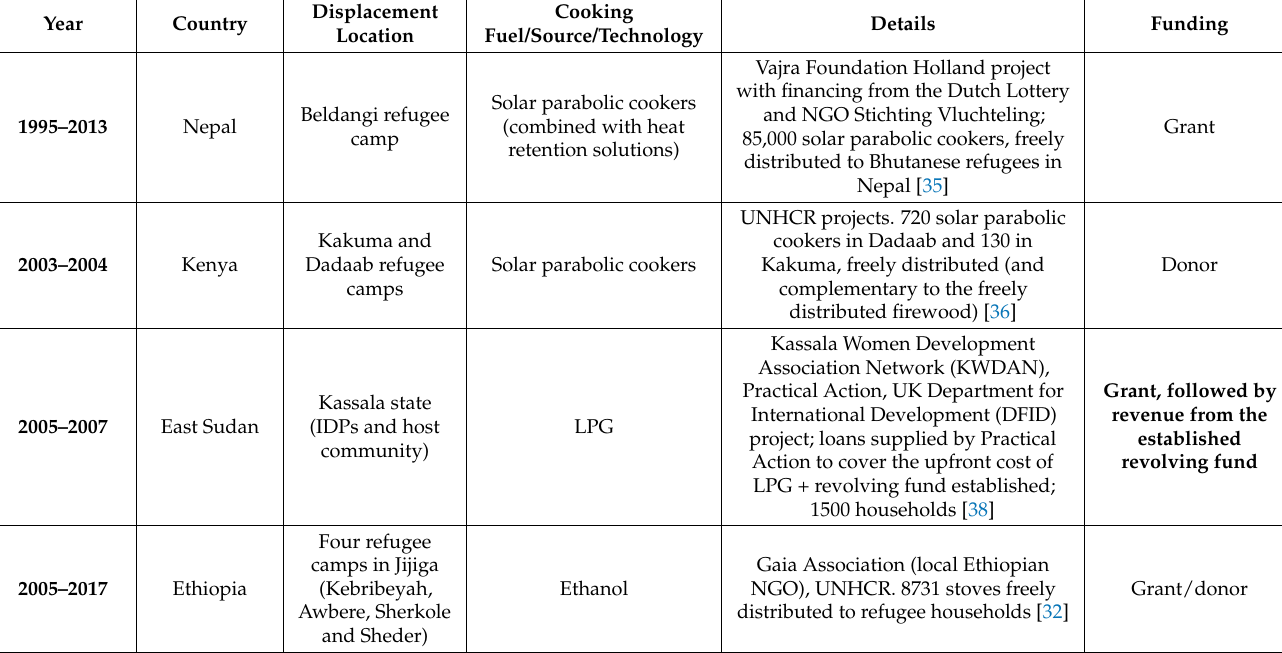
Table 1. MECS projects in displacement settings (1995–2021). Marked in bold under ‘Funding’ are MECS projects which had a component of non-grant/donor funding or innovative financing. Adapted from Tran, Bisaga and To [40] (pp. 27–28) and